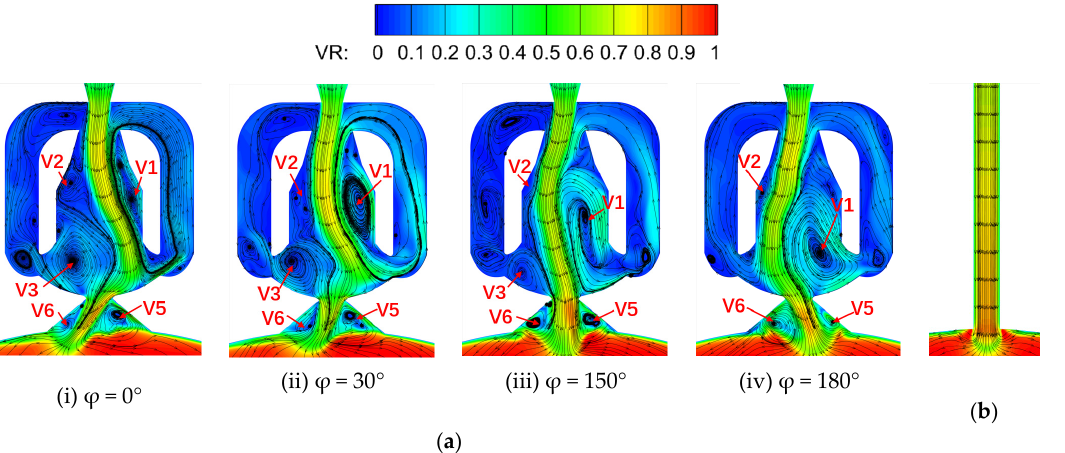
Figure 7. Velocity magnitude for total pressure = 140 kPa: ( a ) instantaneous velocity magnitude of fluidic oscillator at various moments ( ϕ is the phase angle); ( b ) time-averaged velocity magnitude of air